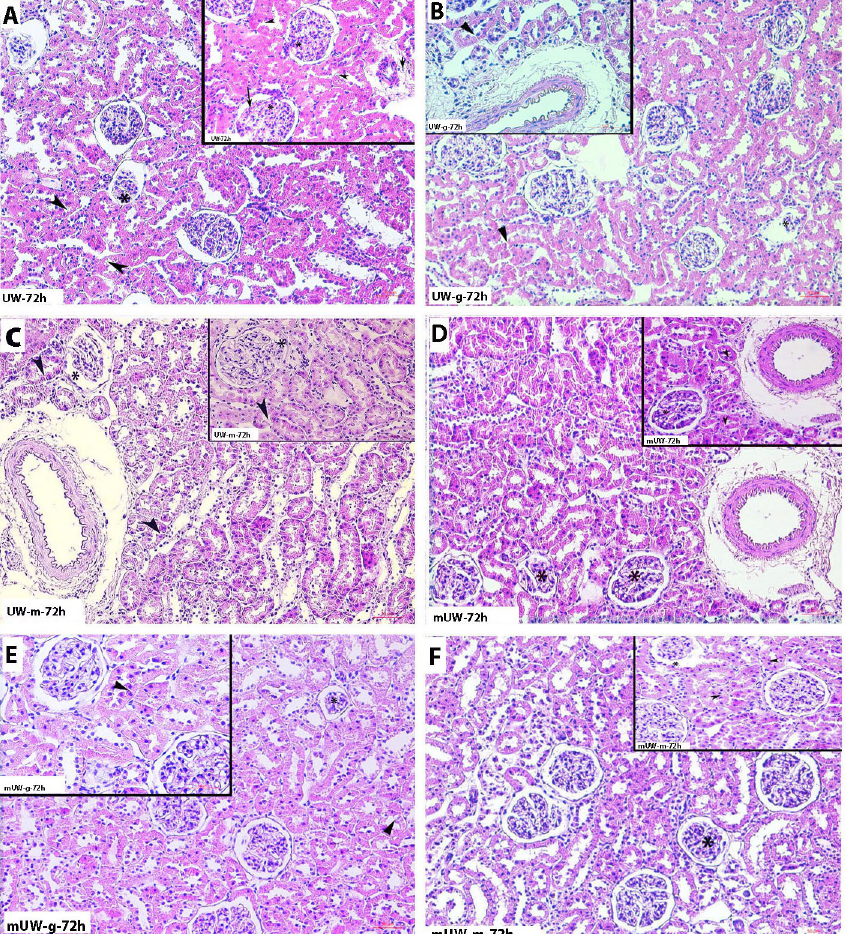
Fig 4. Photomicrographs of kidney tissues stored for 72 hours in experimental kidney preservation solutions. Severe glomerular degeneration (asterisk), tubular degeneration (arrowhead) and inflammatory cell infiltration (short arrow) in UW (A) group. Glomerular (asterisk) and tubular degeneration (arrowhead) in UW-g (B) and UW-m (C) groups. Both the extent and the degree of renal glomerular (asterisk) and tubular degeneration (arrowhead) were apparently lower in mUW (D) and mUW-g (E) groups. Mild glomerular (asterisk) and tubular degenerations (arrowhead) in mUW-m (F) group. H&E staining, A,B,C,D,E,F x200 magnification, insets: x400